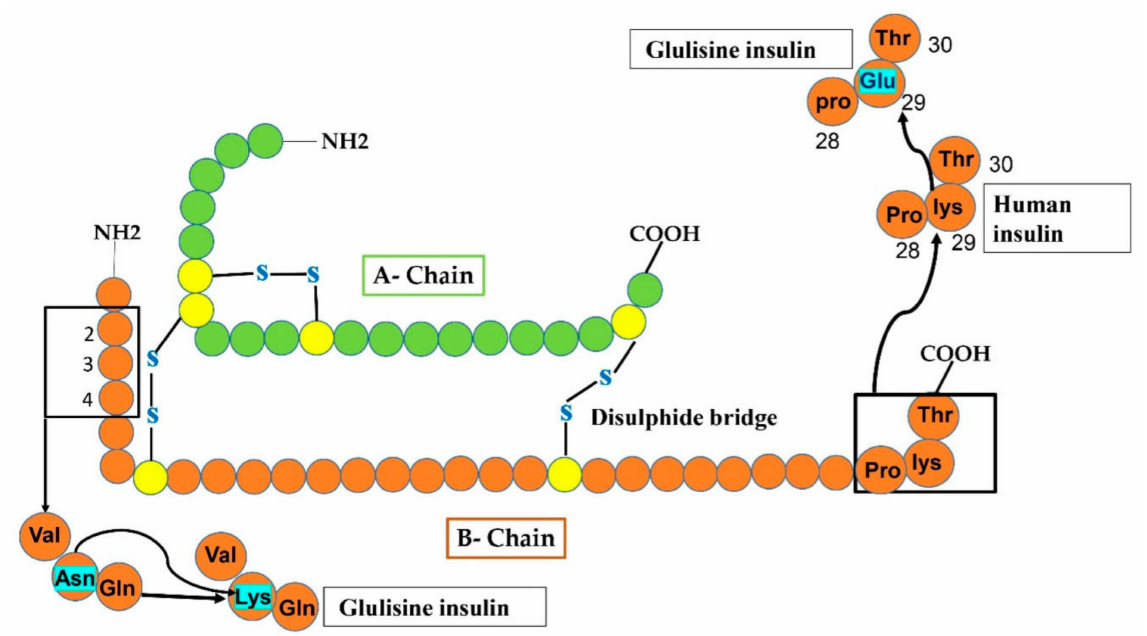
Figure 4. In Glulisine analog, replacement occurs at two sites of the B-chain after the modification of human insulin. At carboxy-terminal, glulisine residue substituted lys residue at position 29, while at amino-terminal, lysine amino acid substituted Asn (shown by sky-colored